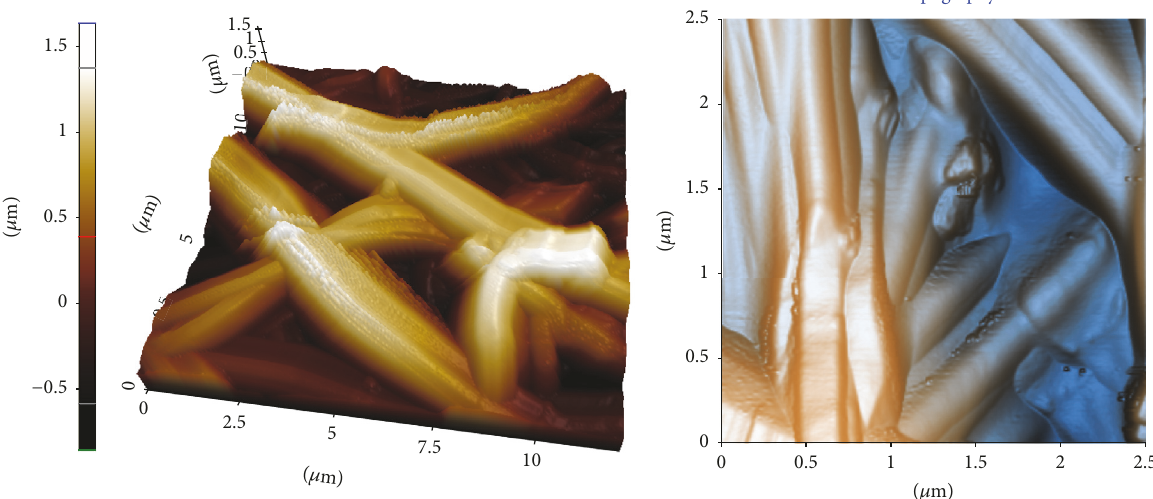
Figure 3: 3D and 2D AFM images of alginate nanocomposite scaffolds.